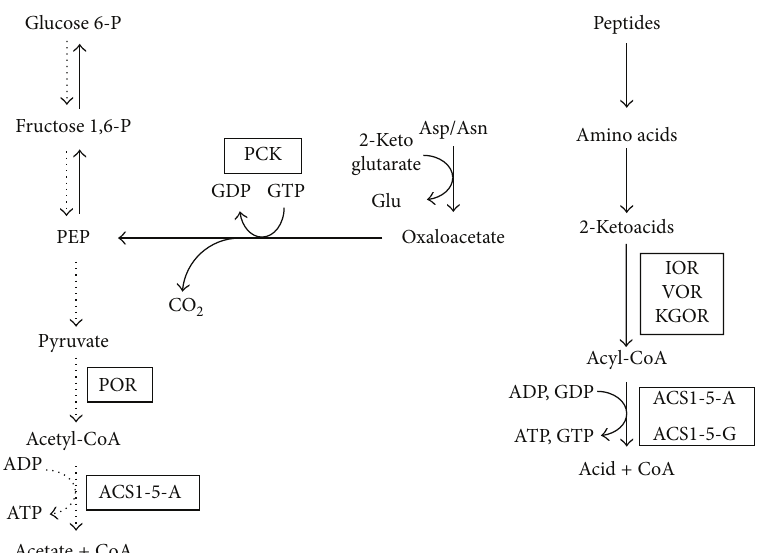
Figure 3: Proposed function of ACS 𝛽 -G and ACS 𝛽 -A isoenzymes during growth of P. furiosus on carbohydrates or peptides. The abbreviations are: POR, pyruvate ferredoxin oxidoreductase; KAOR, 2-keto acid oxidoreductases (IOR, VOR, KGOR and POR, see text for details).